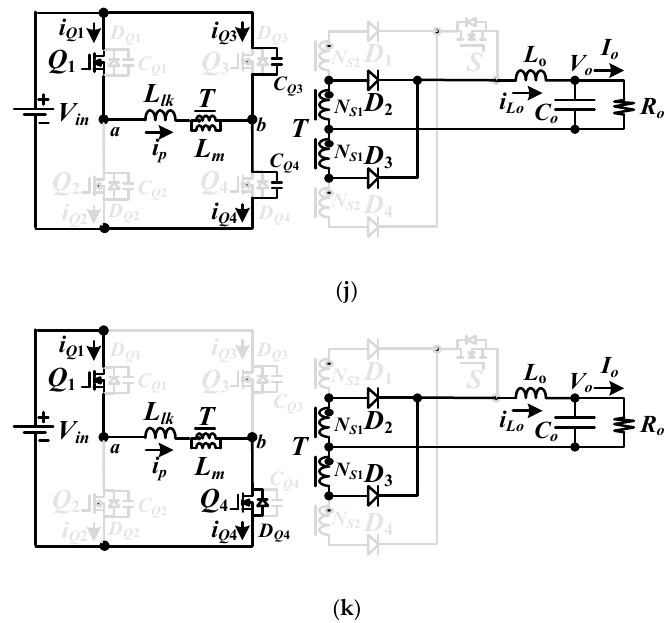
Figure 3. Proposed converter for high input voltage range ( a ) pulse-width modulation waveforms ( b ) mode 1 circuit ( c ) mode 2 circuit ( d ) mode 3 circuit ( e ) mode 4 circuit ( f ) mode 5 circuit ( g ) mode 6 circuit ( h ) mode 7 circuit ( i ) mode 8 circuit ( j ) mode 9 circuit ( k ) mode 10 circuit.